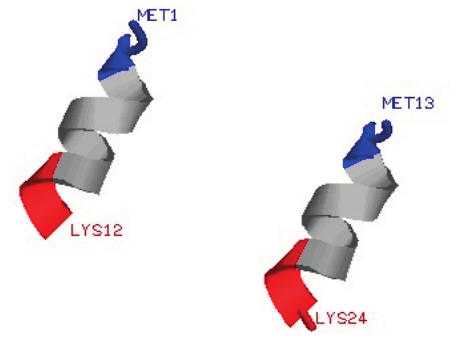
Figure 5. The initial structure of ( α -syn12) 2 used in the T-REMD